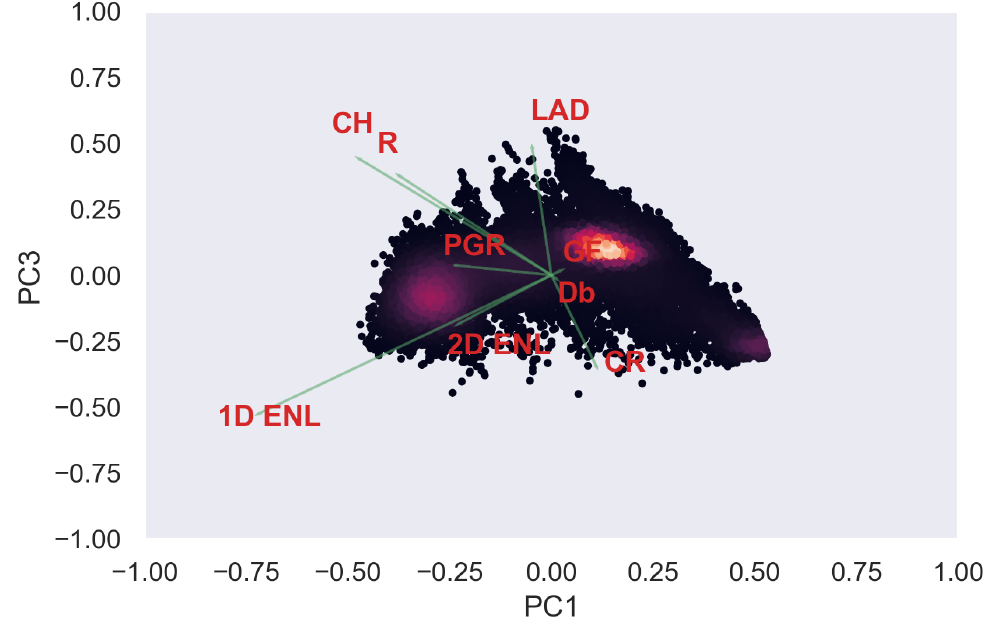
Figure A17. TLS PCA band 1 and 3 loadings at 0.5 m grid